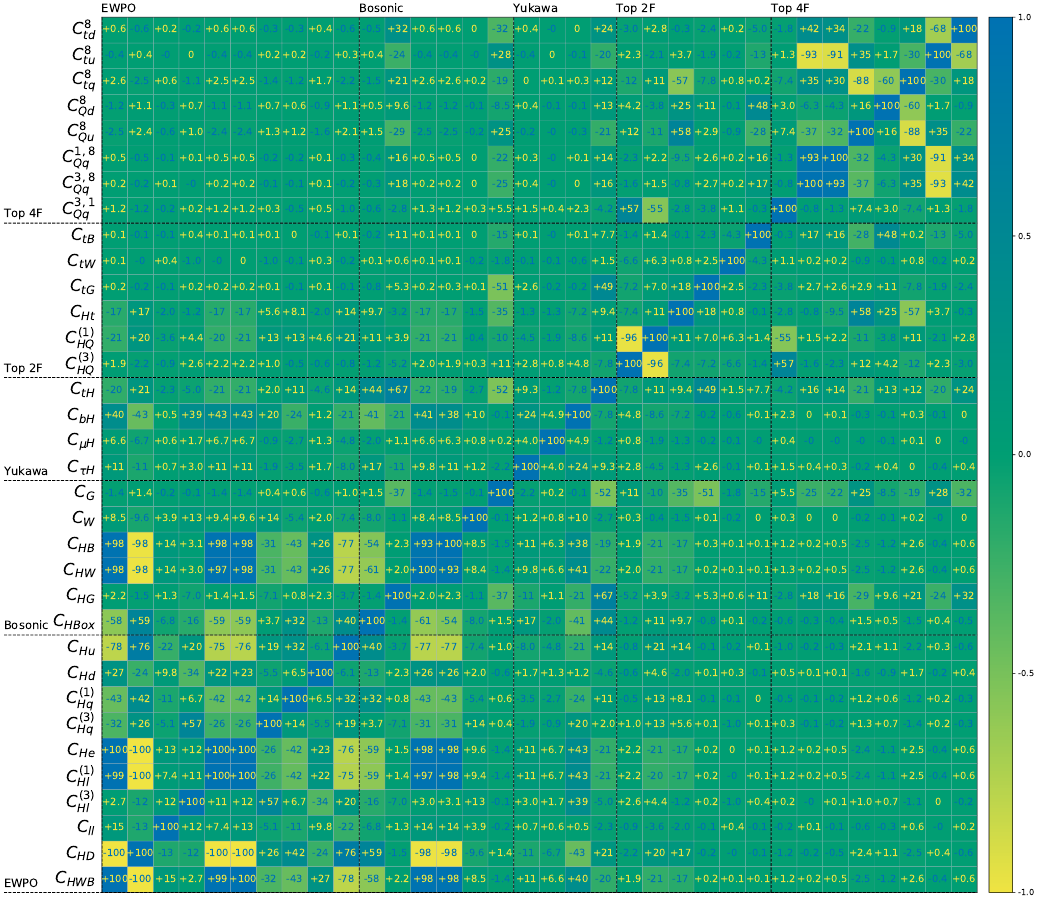
Figure 12 . The full 34 × 34 correlation matrix for the marginalised top-specific fit. The operators are grouped into those affecting primarily electroweak precision observables, bosonic observables, Yukawa measurements and top electroweak measurements, as well as top-quark four-fermion oper- ators. The entries in the correlation matrix are colour-coded according to the indicated magnitudes of the correlation